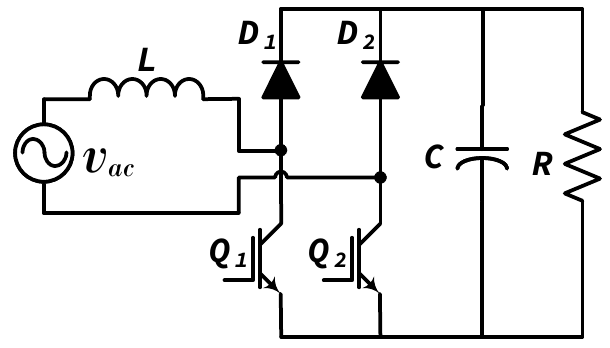
Figure 7. Semi-bridgeless boost converter topology.